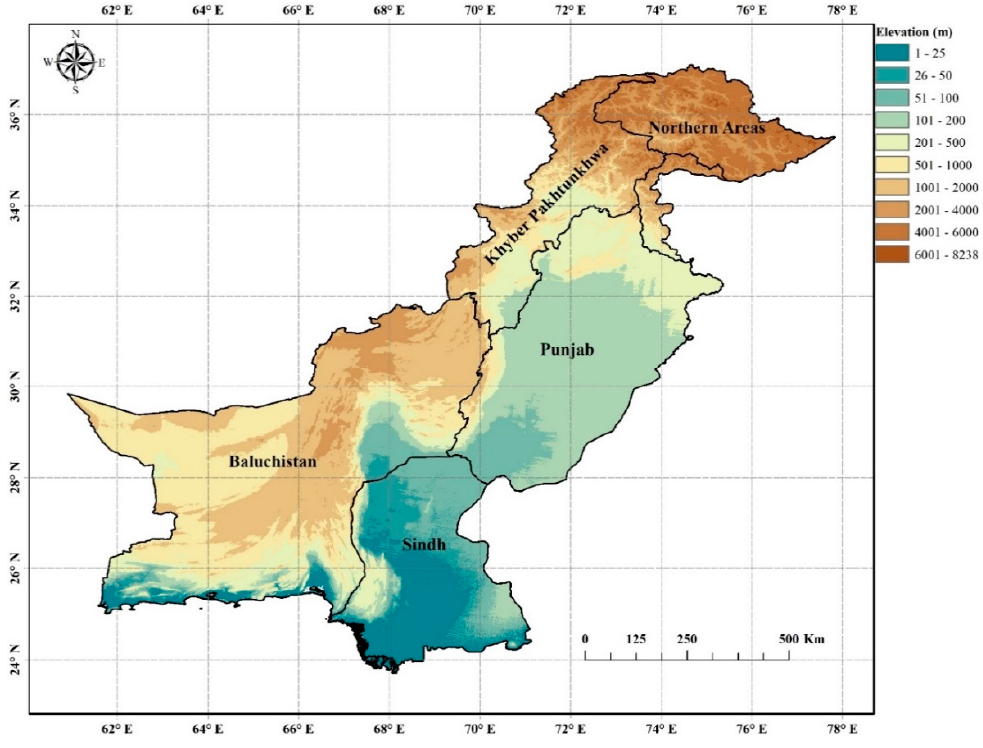
Figure 1. Elevation map of Pakistan.